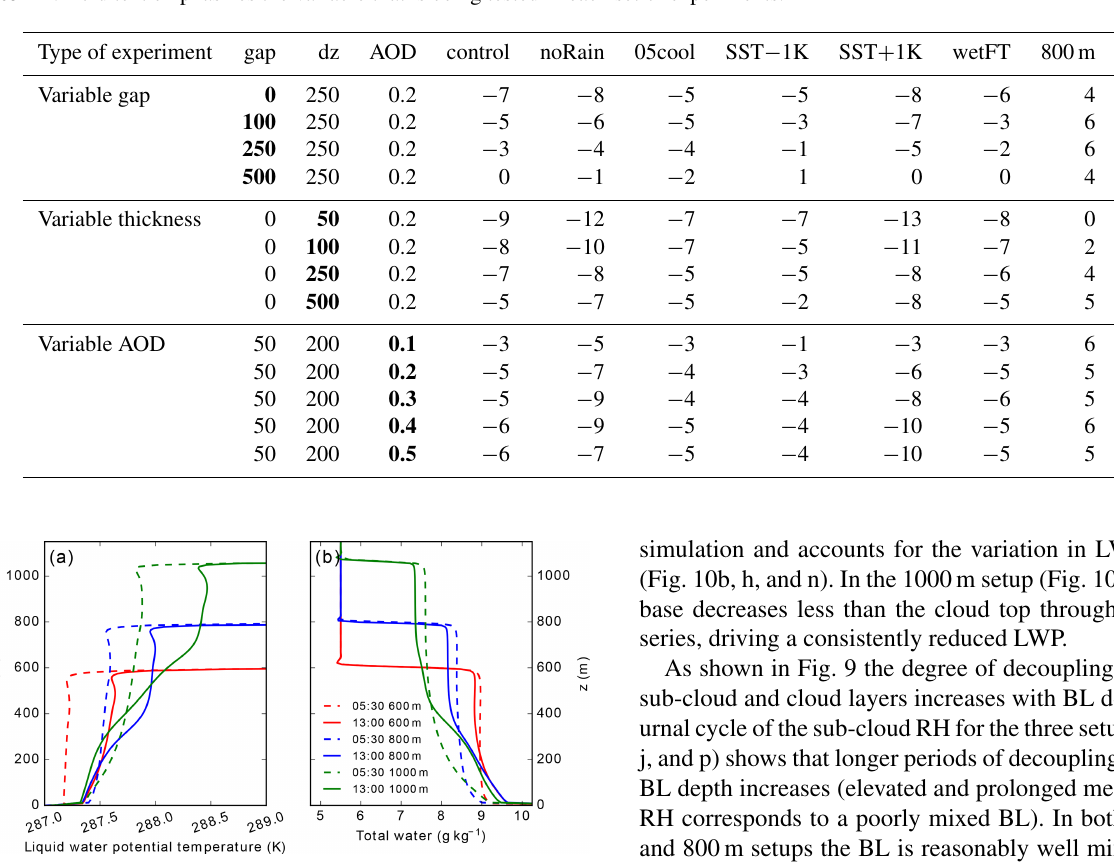
Figure 9. Vertical profiles of (a) liquid water potential temperature and (b) total water mass mixing ratio taken at 05:30 (dashed lines) and 13:00 (solid lines) on day 1 (after spin-up) for the no-aerosol